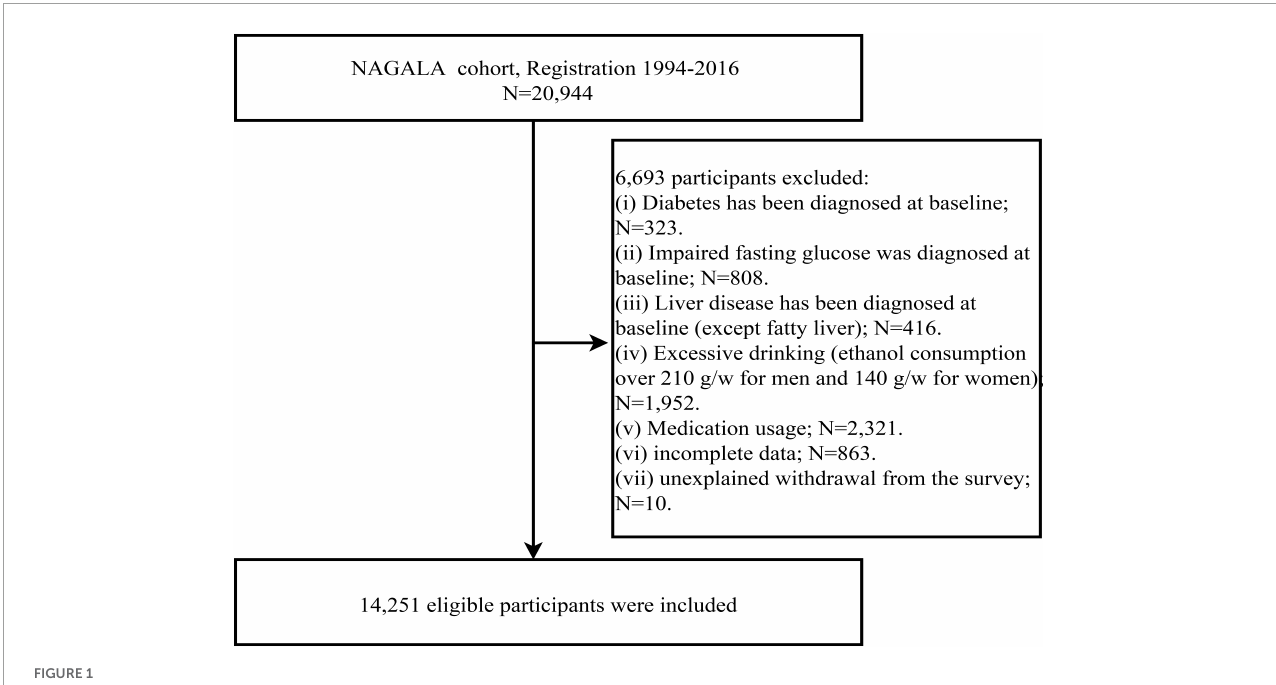
FIGURE1 Flowchart of the selection process of study